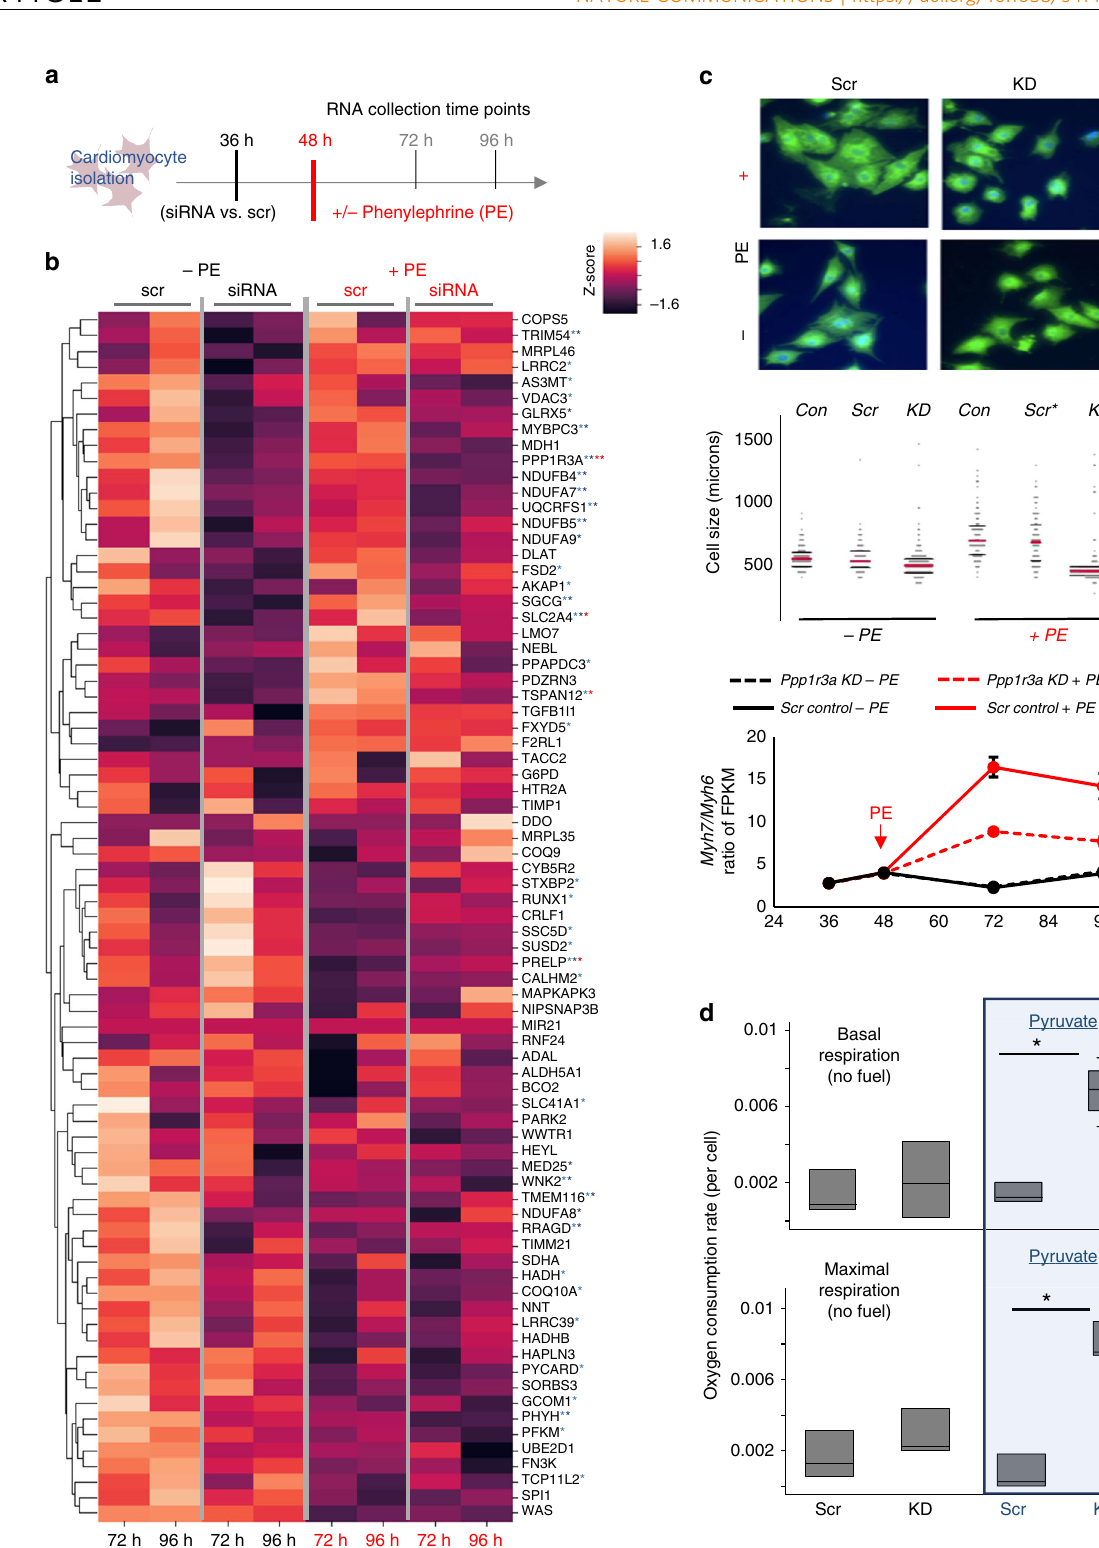
PPP1R3A in striated muscle glycogen metabolism, we hypothe- sized that PPP1R3A ’ s role in the development of HF was related